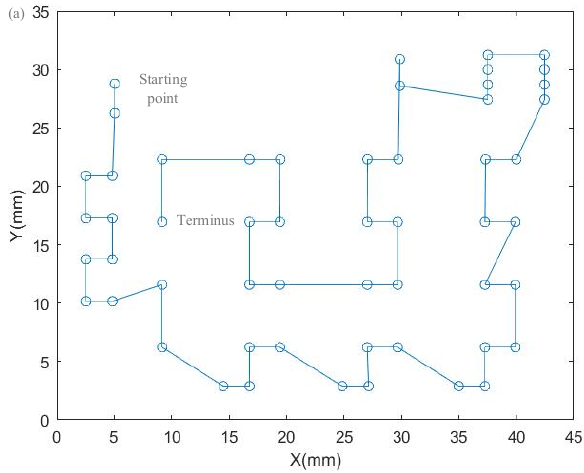
Sensors 2022 , 22 , 8120